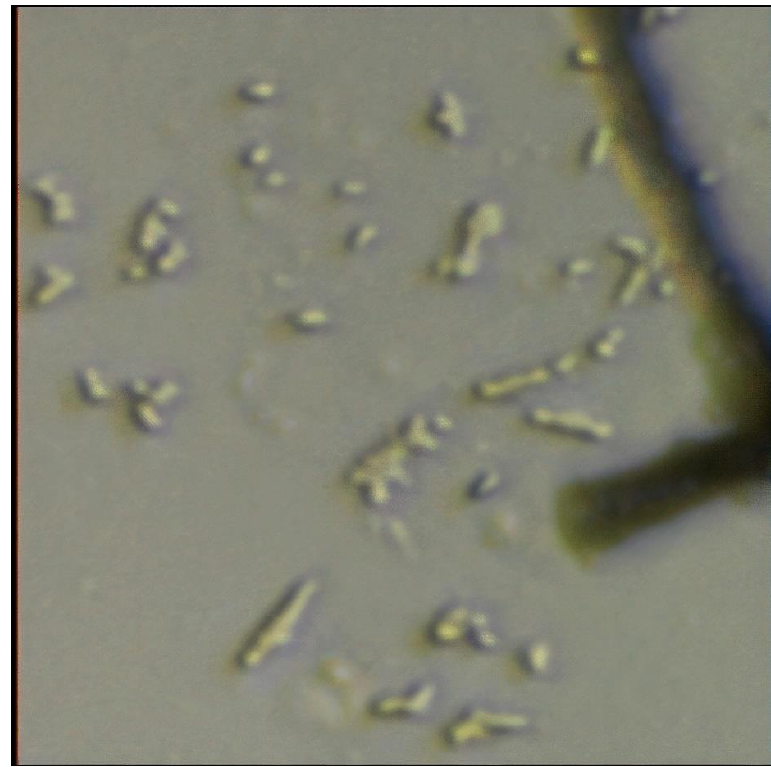
Figure 7. Microscope view (40×) of bacteria and poplar shavings.